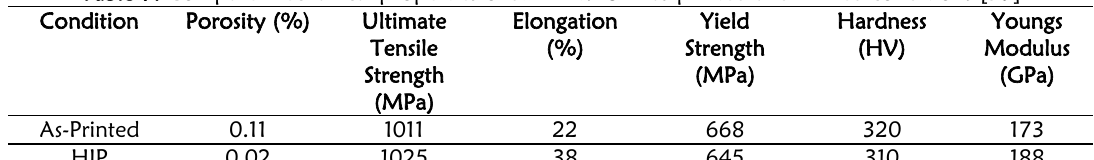
Table 7: Compare mechanical properties of SLM IN718 in as-printed and HIP’ed conditions [59]